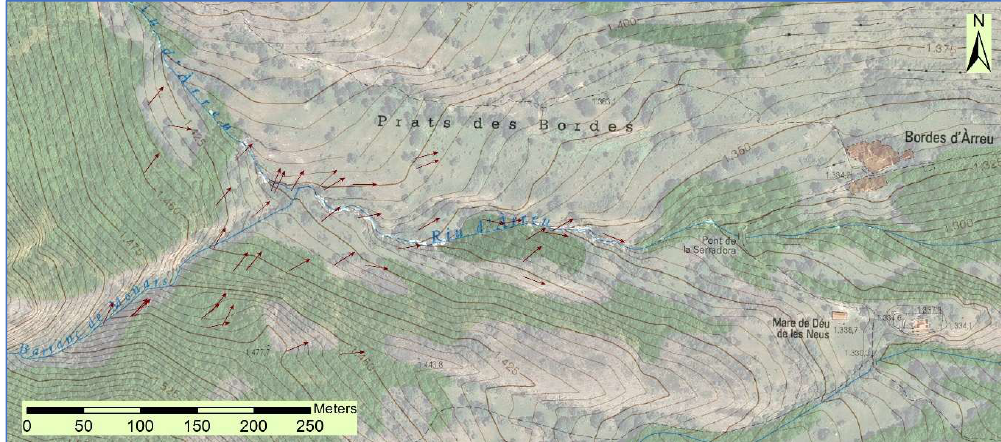
Figure 12. Leaning directions of trees with growth-disturbance evidence most likely caused by avalanches in the lower section of the Monars torrent, the confluence with the Àrreu river, and the meadows above the old village (dark